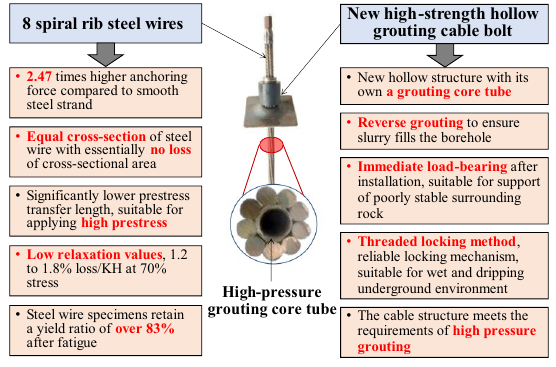
Fig. 21 New hollow grouting cable bolt made of spiral rib steel